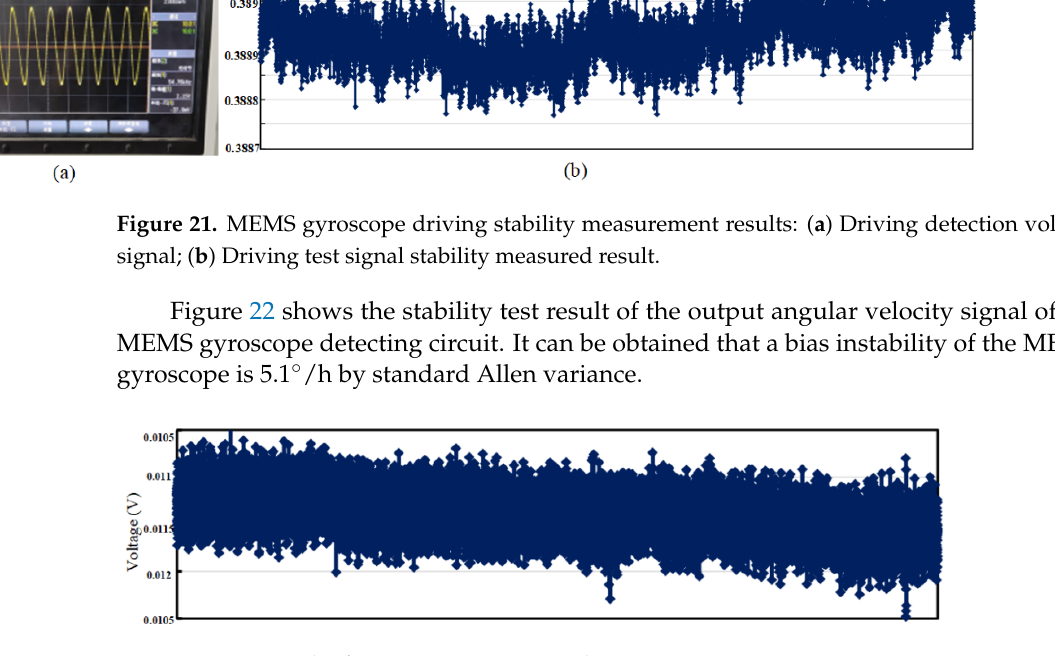
Figure 23. MEMS gyroscope test circuit input and output test results ( a , b ).